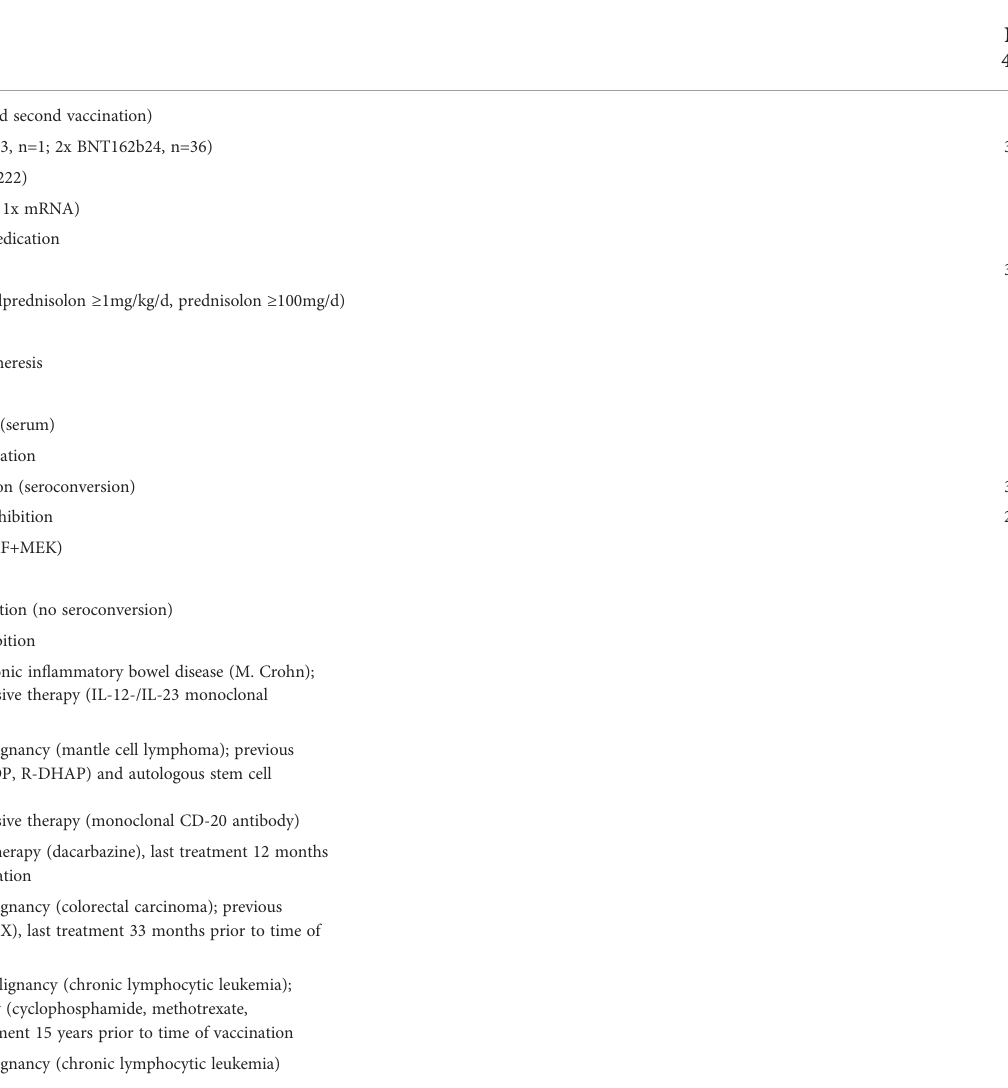
TABLE 2 COVID-19 vaccination and